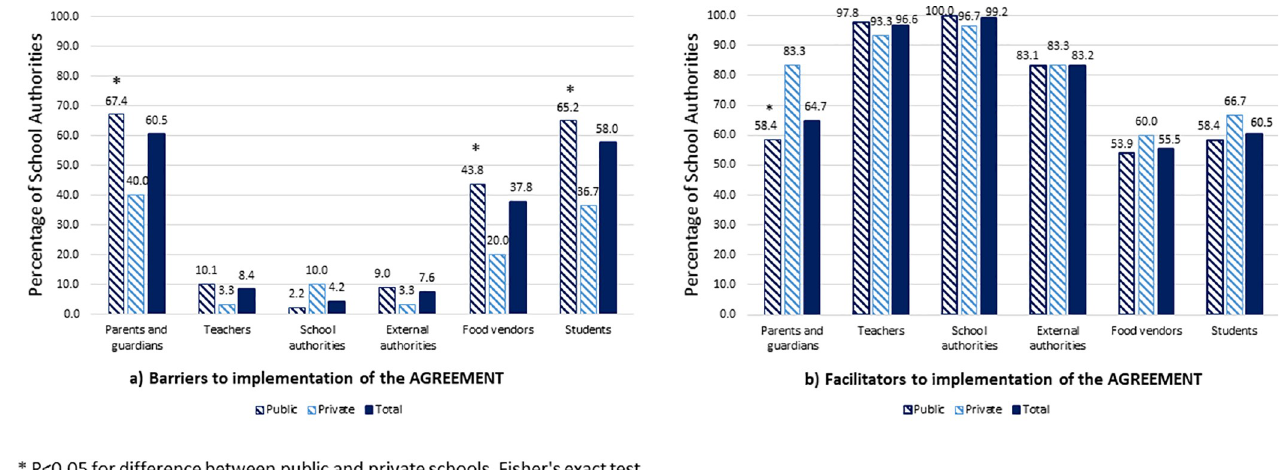
Fig 2. Groups or individuals that are a) barriers to or b) facilitators for implementation of the AGREEMENT–reported by the school authorities (n = 119).